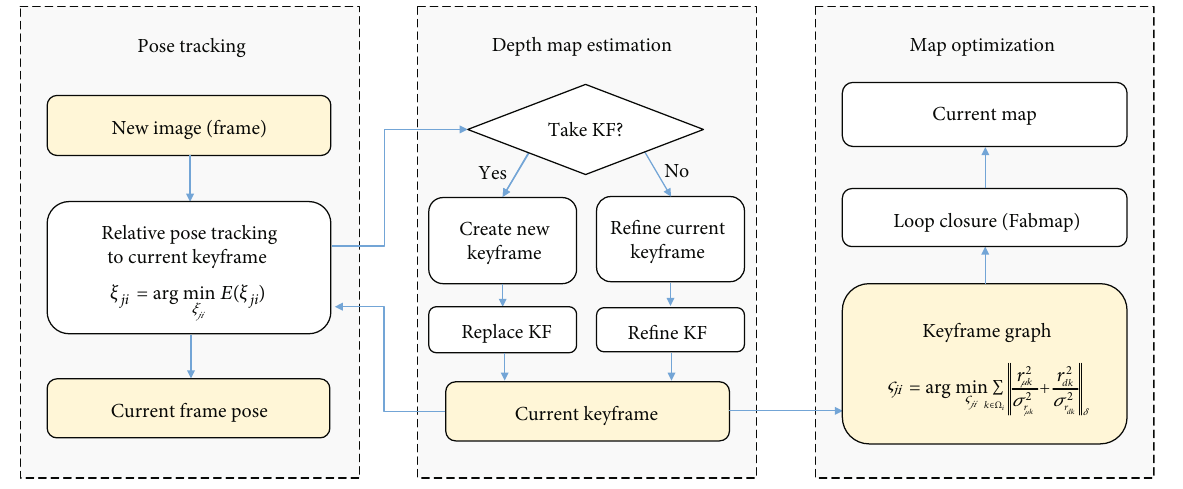
Figure 2: A broad outline of the LSD-SLAM